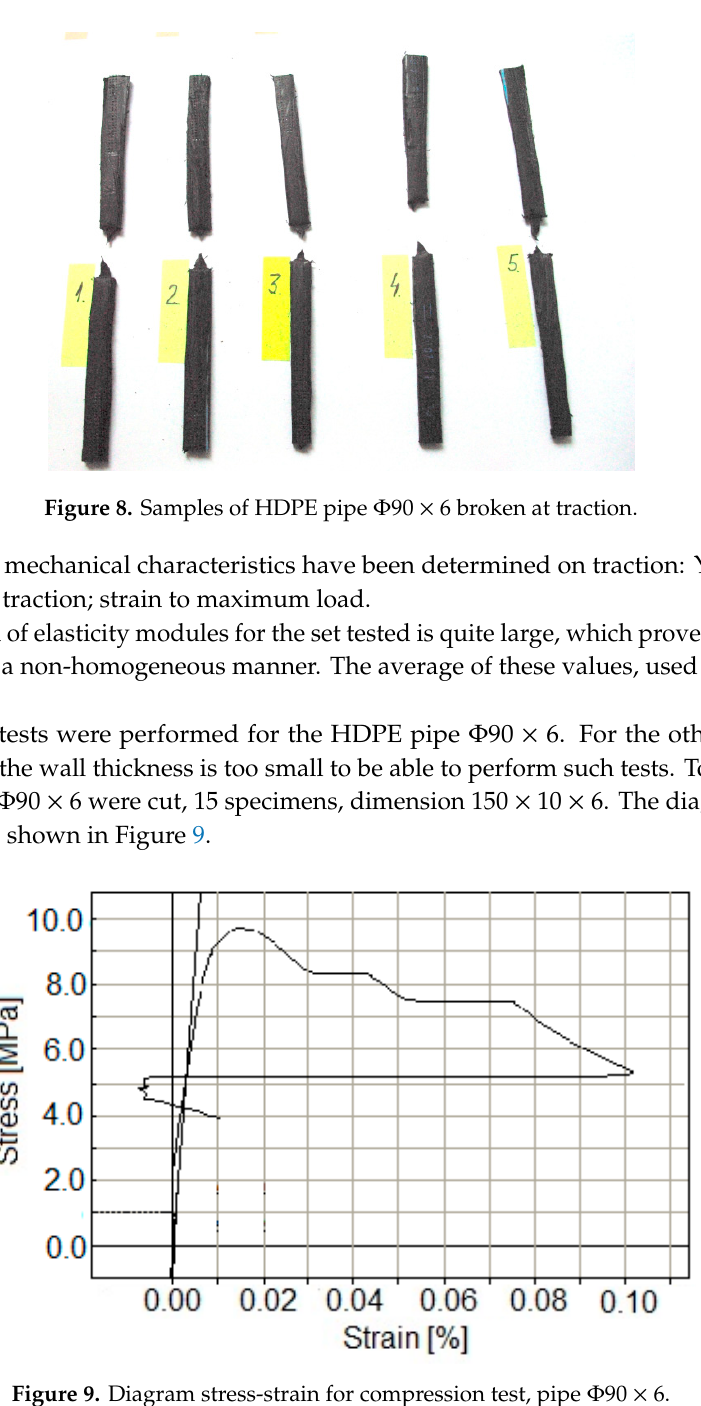
Figure 9. Diagram stress-strain for compression test, pipe Ф 90 × 6.